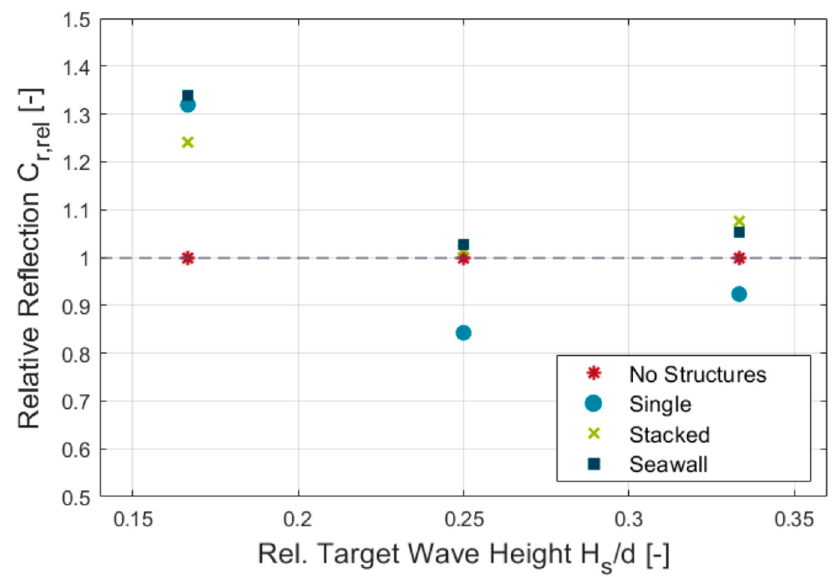
Figure 14. Relative reflection from each beach-structure type in relation to the beach with No Structures for all three tested wave conditions. Values determined from equilibrium profile.